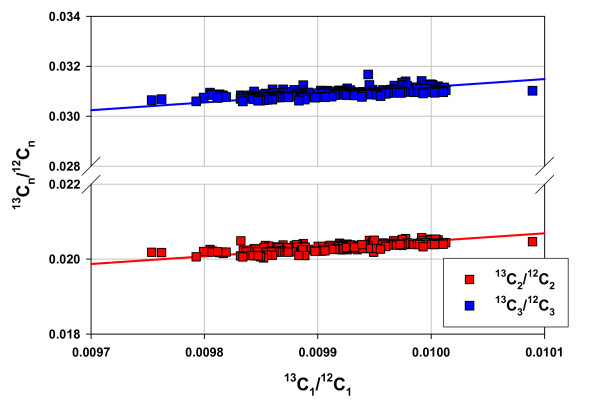
The correlations between molar isotope ratios in methane, ethane, and propane in 285 gases (USGS, Table 1). Ratios are molar, calculated as described in Table 1. The lines are linear regression lines with a coefficients of correlation R2 = 0.638 for 13C2/12C2 with slope (zero intercept) = 2.028, and R2 = 0.47 for 13C3/12C3 with slope (zero intercept) = 3.055.